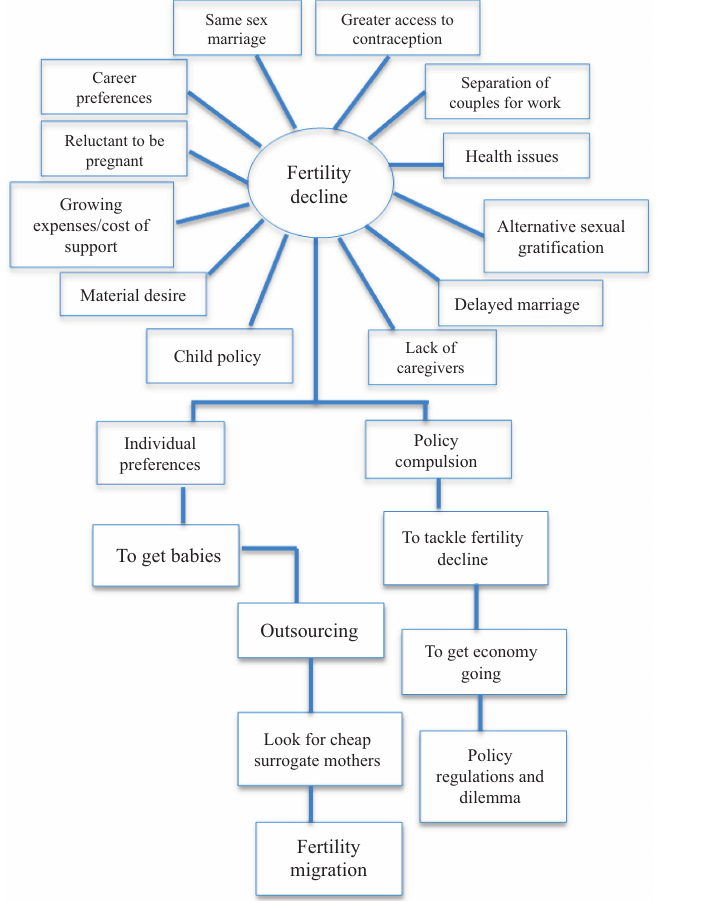
Figure 1. Fertility Decline and Fertility